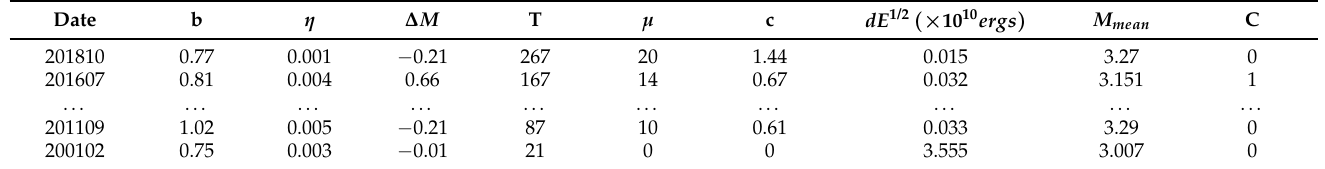
Table 4. Partial eight indicators and label of Sichuan province after preprocess.